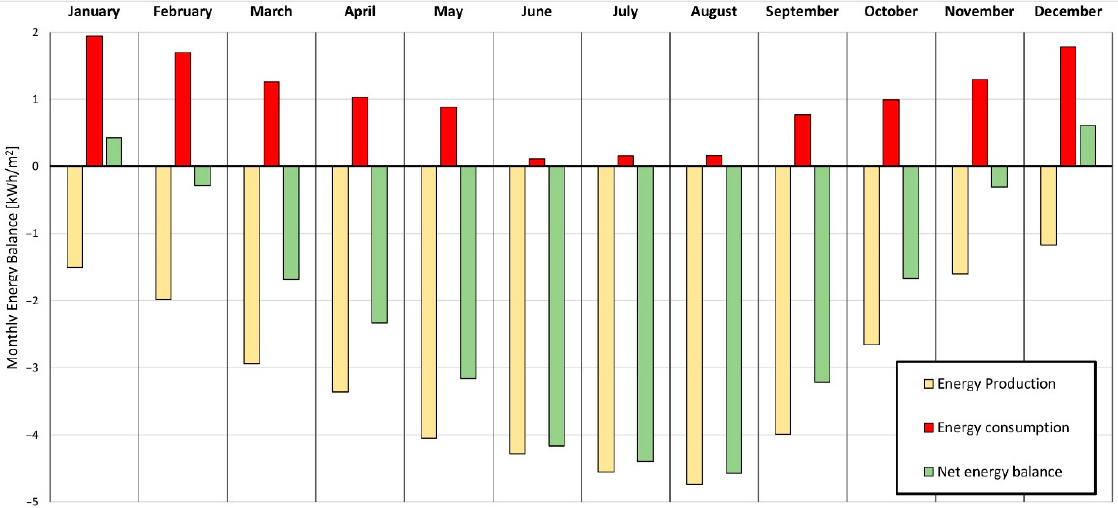
Figure 15. Energy balance (kWh/m 2 yr) for Poliziano school for each month considering the optimized configuration. In the graph, the energy production of the PV panels (yellow), the energy consumption of the building (red), and the net energy balance (green) are illustrated. A positive value of the net energy balance means that the building needs electrical energy from grid, while a negative value means a surplus electrical energy production that could be fed into the public grid.